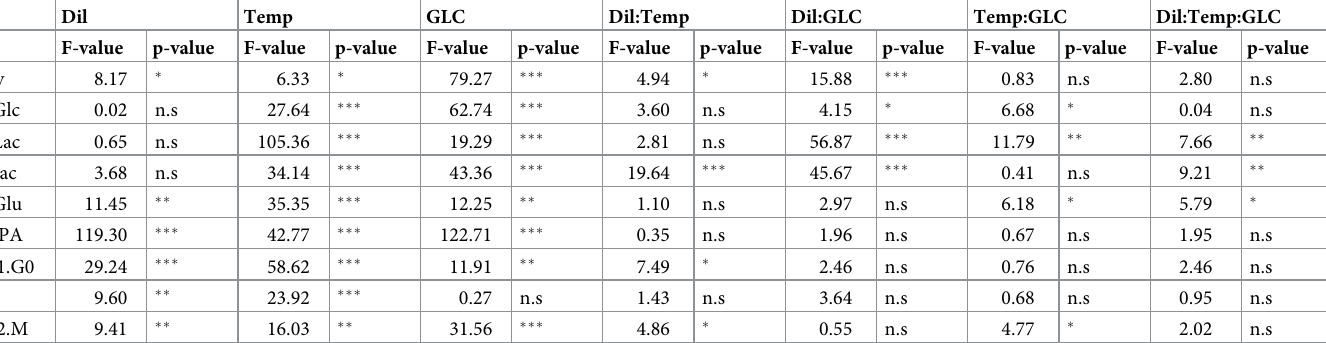
Table 2. Individual and combined impact of dilution rate, culture temperature and feed glucose concentration on the physiological parameters in chemostat cul- tures at steady state (MANOVA; n = 3). Dil Temp GLC